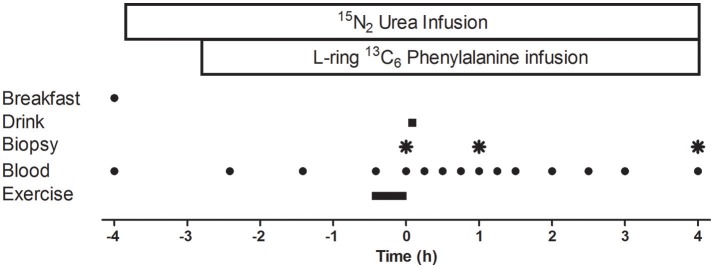
Schematic diagram of the infusion protocol. A baseline blood sample was collected before participants consumed an energy-rich, high-protein breakfast. A bout of unilateral leg-resistance exercise was performed 3 h after breakfast. Muscle biopsies (vastus lateralis) were collected from the exercised leg immediately prior (0 h), 1-, or 4 h-post drink ingestion. Drink ingestion was either a branched-chain amino acid containing beverage (BCAA) or placebo (PLA). Multiple blood samples were collected throughout the protocol. Ex, exercise.